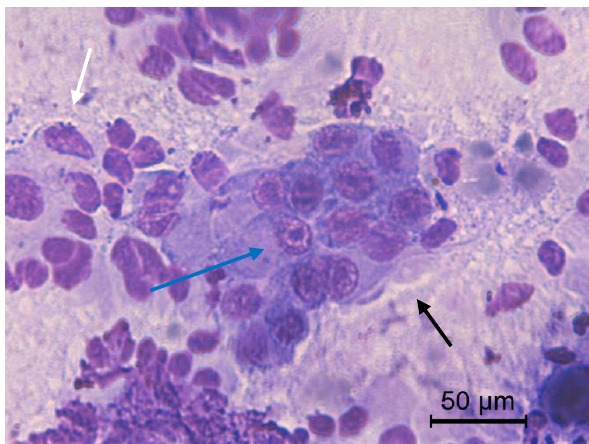
Figure 6. Jenny’s endometrial cytology collected by CB in estrus. Tall (black arrow) and low (white arrow) columnar endometrial epithelial cells. Evident nucleoli (blue arrow). Dense and proteinaceus background present. Modified Wright’s stain 400 × .